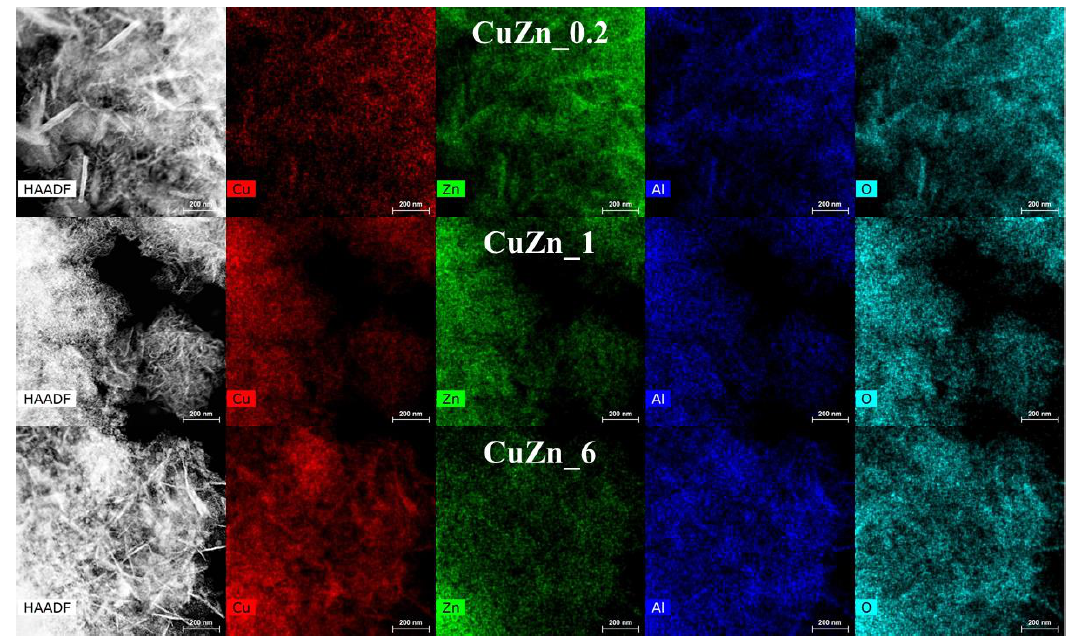
Figure 6. EDX images of CuZn_0.2, CuZn_1 and CuZn_6. (Scale bar: 200 nm).